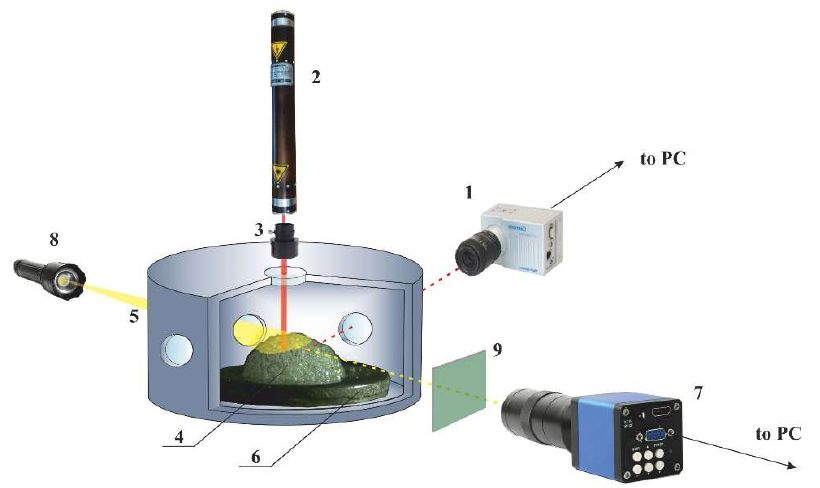
Figure 1. The scheme of the experimental setup.